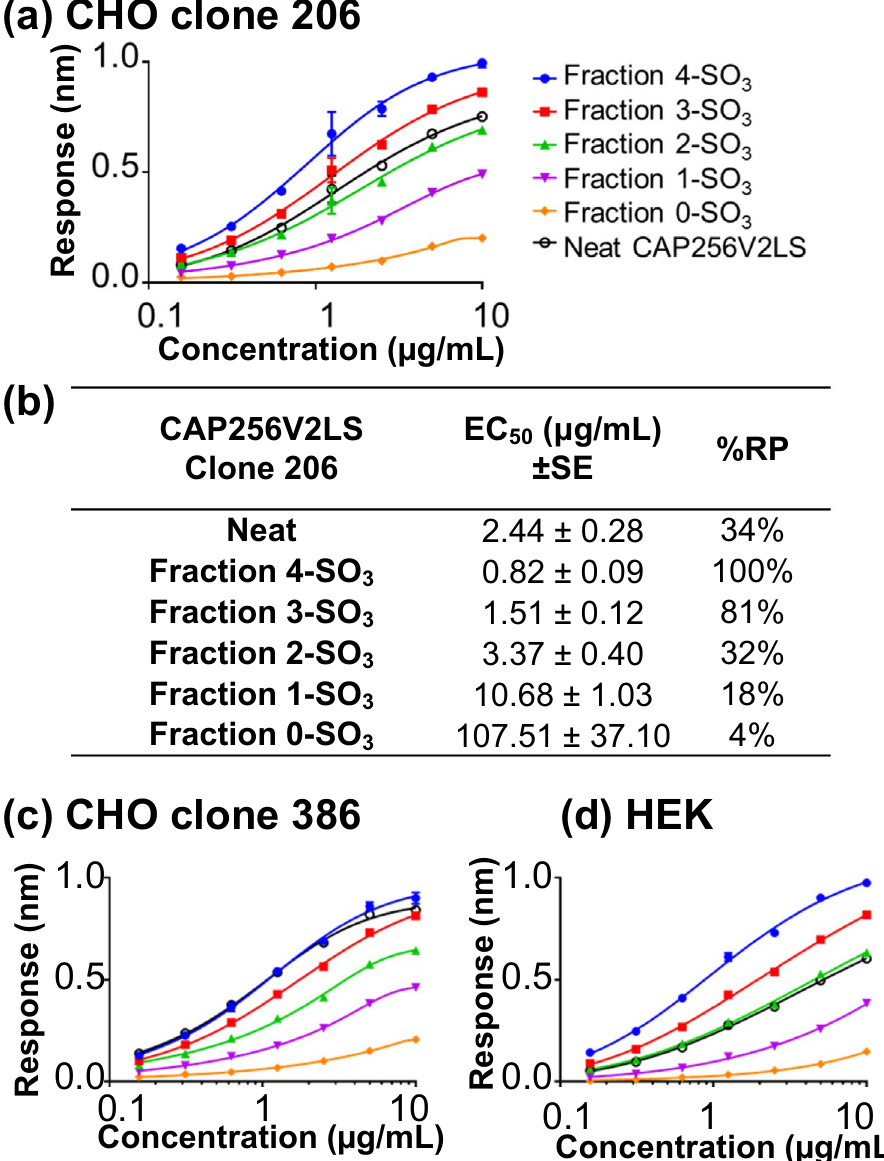
Figure 2. Increased levels of CAP256V2LS tyrosine sulfation correspond to increased antigen binding. ( a ) Octet antigen-binding curve for fractions of CAP256V2LS generated from CHO clone 206. ( b ) Relative antigen binding potency (%RP) for each level of tyrosine sulfation proteoform of CAP256V2LS. Octet antigen-binding curve for fractions of ( c ) CHO clone 386 and ( d ) CAP256V2LS expressed in HEK-293 cells. %RPs were normalized against the highest 4-SO 3 proteoform from the same parent material. Binding curve data points shown as average with error bars are from two independently prepared